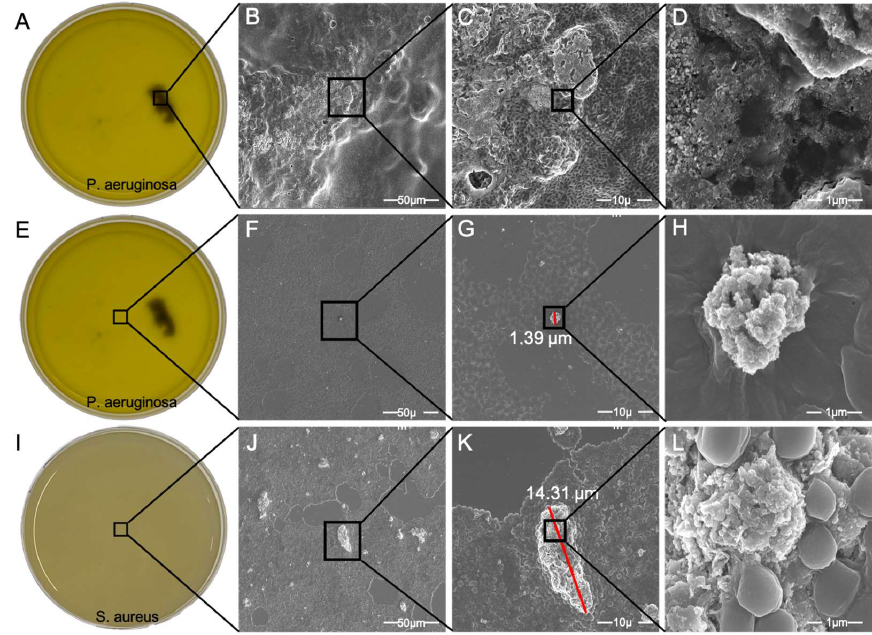
P. aeruginosa ( E – H ) and medium of S. aureus ( I – L ). The images show the structure of the